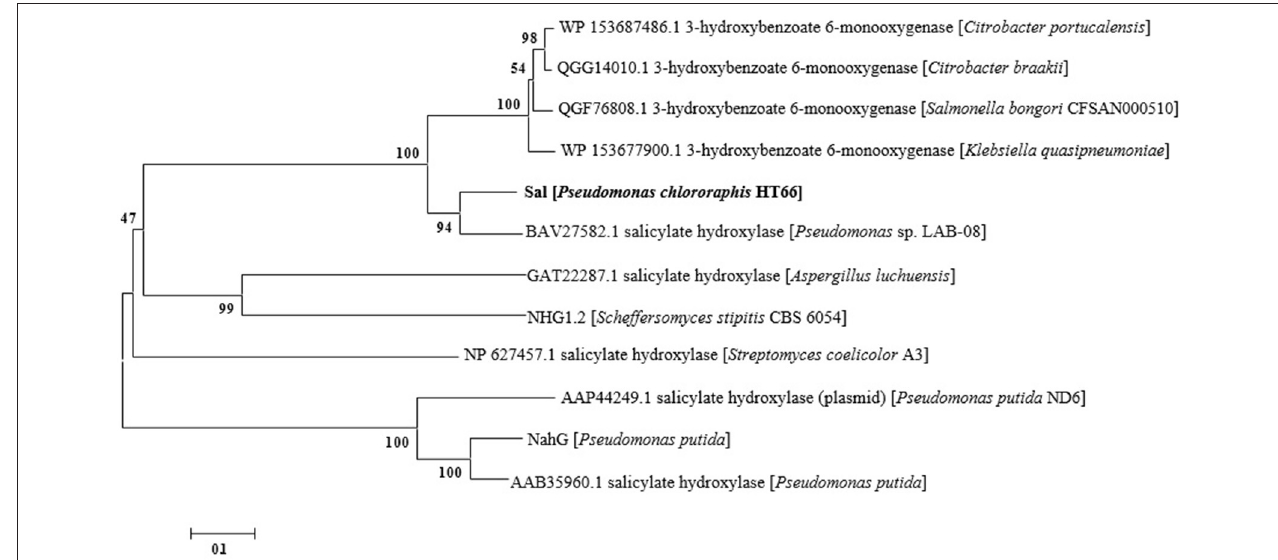
FIGURE 6 | Phylogenetic tree of of 3-hydroxybenzoate 6-hydroxylase, salicylate hydroxylase and Sal. The ruler at the bottom of figure indicates the horizontal distance equal to 10% sequence